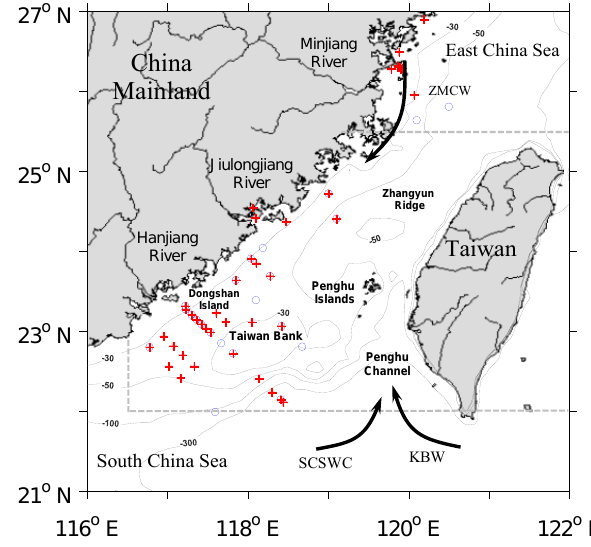
Fig. 1. Map of the Taiwan Strait; ZMCW: Zhe-Min Coastal Water; SCSWC: South China Sea Warm Current; KBW: Kuroshio Branch Water; the red cross and blue circle symbols show the locations where field measured R rs and MODIS R rs have match-up in situ observed absorption coefficients, respectively; the grey lines indicate the boundaries of the research area of this study.